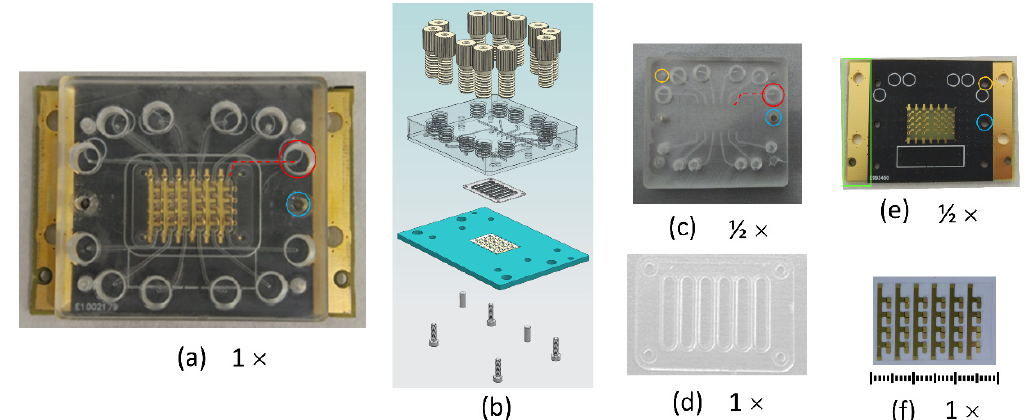
Figure 1. Multichannel Microfluidic Sensor Cartridge. Assembled cartridge ( a ). Schematic of cartridge assembly ( b ) from components (from top to bottom): microfluidic connectors, Poly(methyl methacrylate) (PMMA) cell, Poly(dimethylsiloxane) (PDMS) gasket, Printed Circuit Board (PCB) with the array, assembly screws and alignment pins. Photos of its components: PMMA cell ( c ), PDMS gasket with six channels ( d ), PCB ( e ), and the 24-element HFF-QCMD array ( f , see Figure S1 in the Supporting Information for an enlarged view). Note the difference in scale: ( c ) and ( e ) are shown at half the size relative to ( a ), ( d ), and ( f ), which are drawn to scale. Array dimensions are 14.25 mm × 9.05 mm.